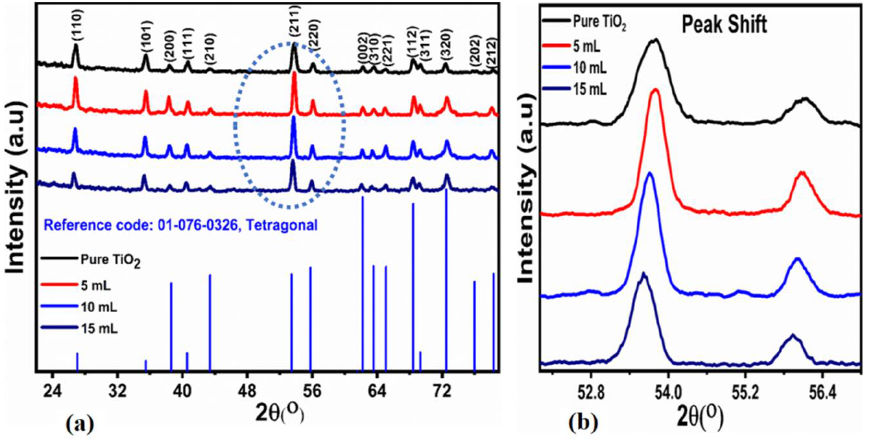
Figure 3. XRD patterns bulk TiO 2 that has been hydrothermally treated ( a ) and treated with 5, 10, and 15 mL of FC leaf extracts ( a ) and peak shift analysis at (211, 220) with increasing amount of Ficus carica (FC) ( b ).